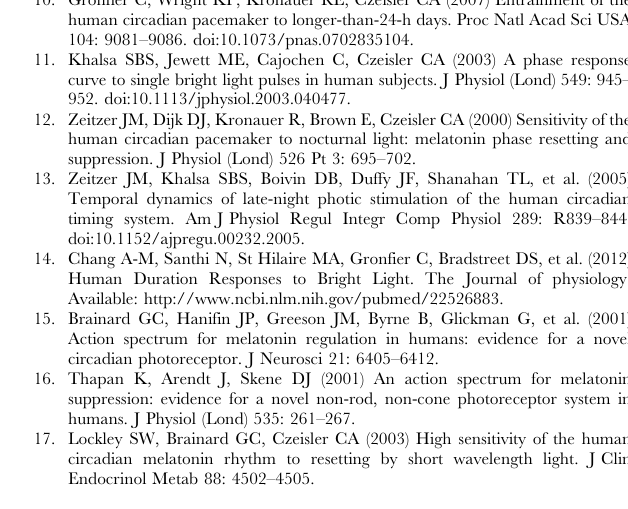
This device was used to monitor continuously individual spectral light exposure during the study. Figure S2 Raster chart of incident spectral light expo- sure (in the average angle of gaze) over 8 weeks. Shown data are a synthesis of measurements collected with LightWatcher personal data loggers from several subjects who were working in comparable light environments. The depicted color values were calculated from the output signals of 3 LightWatcher photodiodes with peak sensitivities around: red (620 nm), green (540 nm), and blue (460 nm), and averaged in 15 minute intervals. Missing data are shown in dark gray color. Figure S3 Relative spectral composition of the SW and BE lighting environments. Whether obtained from manual environmental measurements or from individual proxy of corneal measurements (from data loggers), BE light contained significantly more short wavelength blue light than SW light. Figure S4 Average activity under SW light weeks and BE light weeks. Average daytime and night-time activity was not different between lighting conditions. Figure S5 Melatonin phase change in local time. A. Average DLMO over time, in local time. B. Average DLMO in local time, grouped by light condition. On average DLMOs were significantly delayed during SW light weeks compared to BE light weeks (p , 0.05). Figure S6 Individual change in circadian phase across the 9 week study. Notice that SW light elicited 9 phase delays out of 10 phase changes. This was not the case under BE light. Figure S7 Impact of light condition on neurobehavioral responses over 9 weeks. Results are normalized to week SW1, and are expressed as means 6 SE. Non-significant fluctuations in average sleepiness (A), time estimation (B), motivation (C), and subjective mood (D), are observed across the nine weeks.